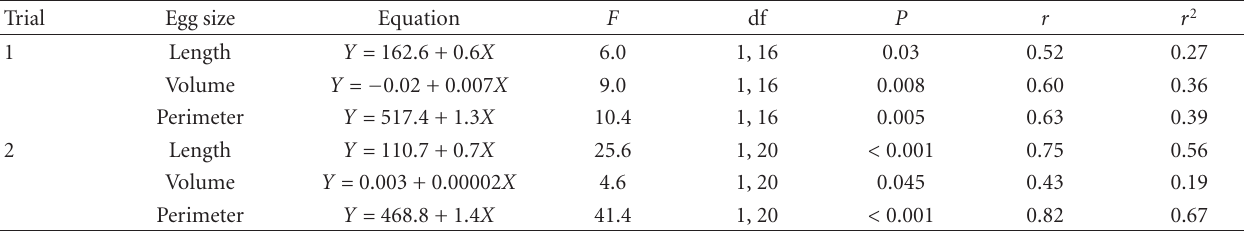
Table 1: Linear regression equations and ANOVA statistics for the relationship of egg size versus femur length of predators (mothers). Trial Egg size